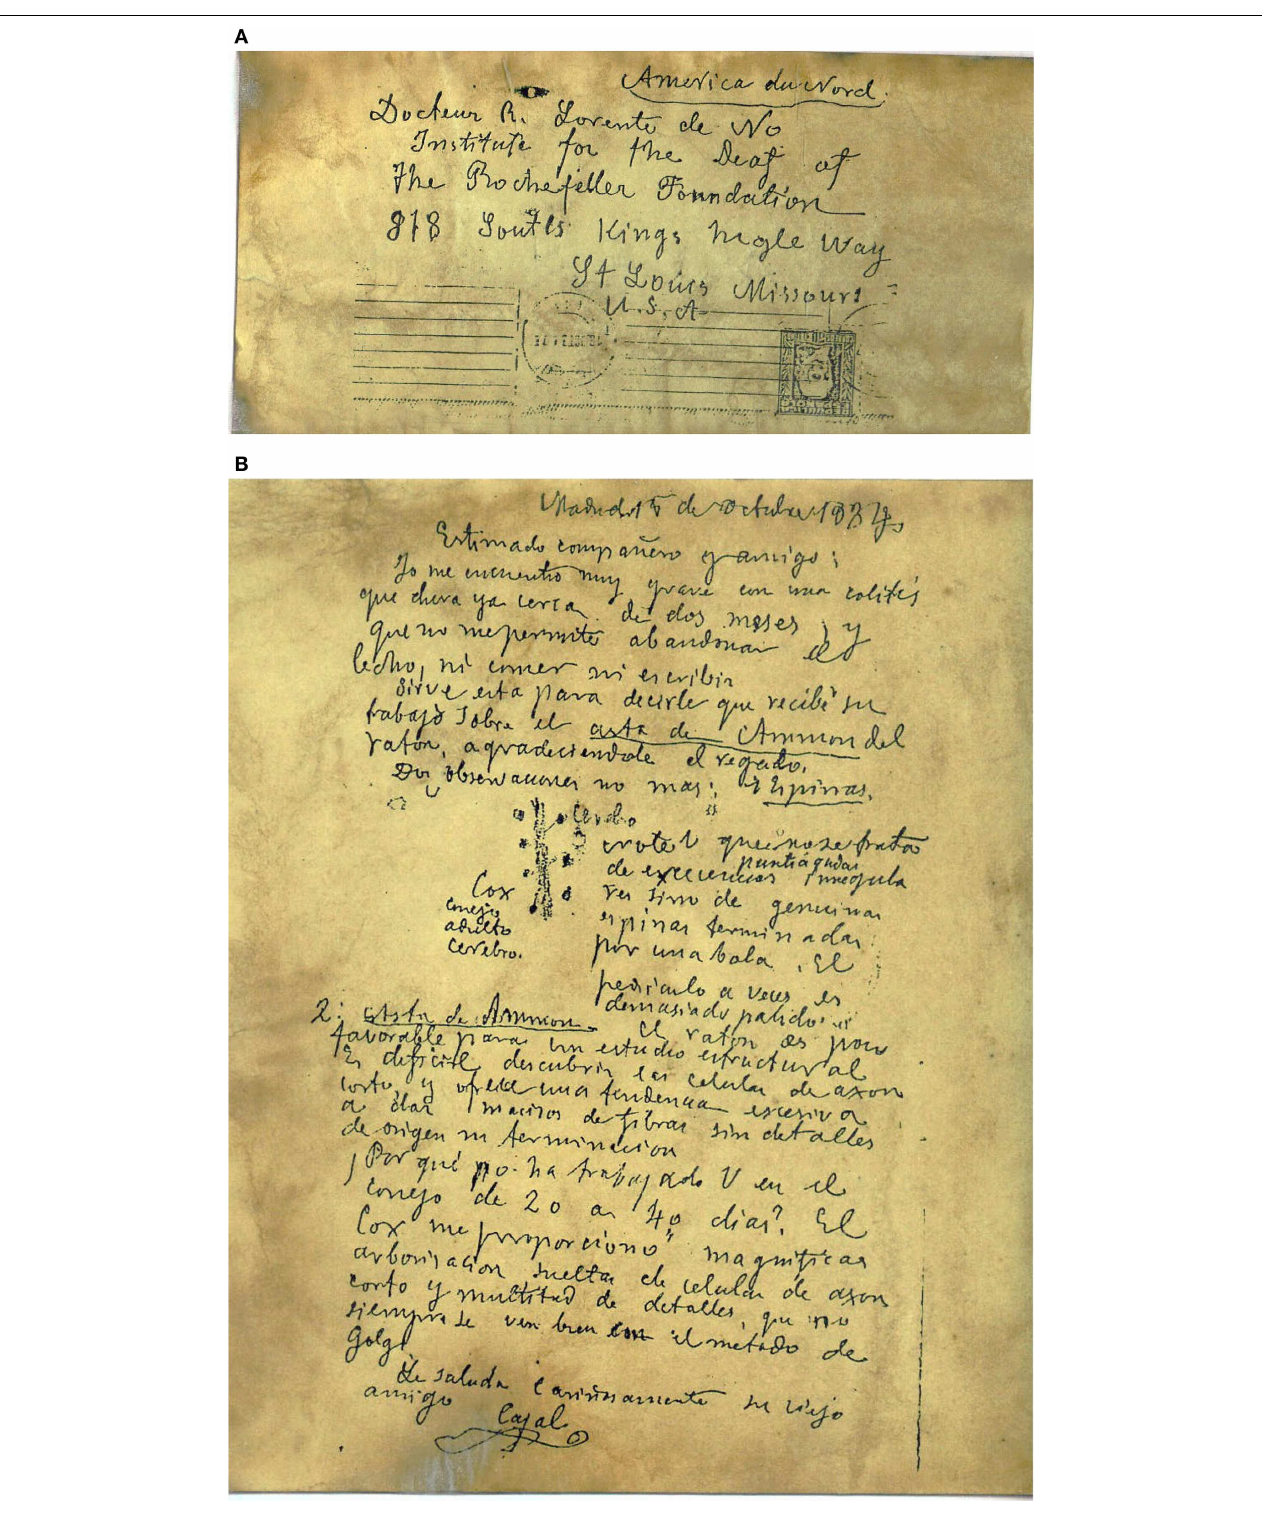
drawing of dendritic spines. Paragraph is translated in the text. Reproduced with permission from “Herederos de Santiago Ramón y Cajal.”